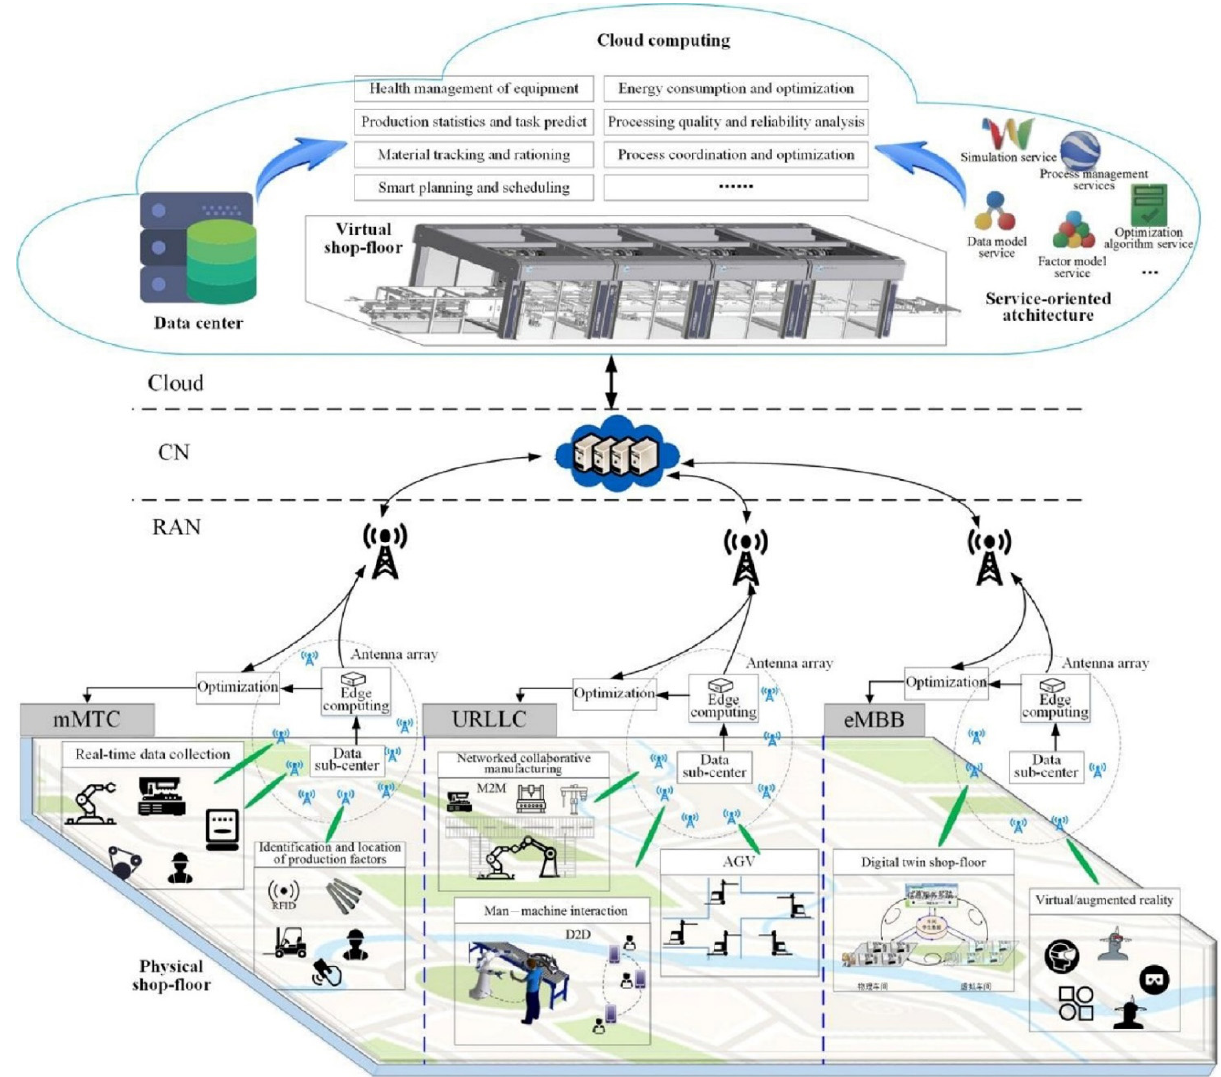
Figure 13. Intelligent manufacturing IIoT architecture based on 5G with permission from [88], 2019, IEEE